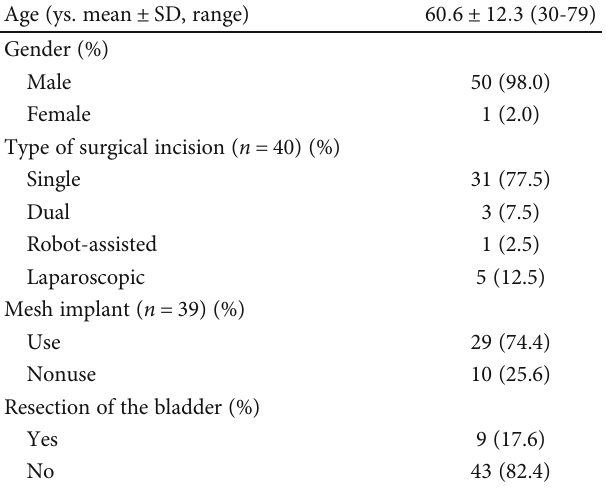
Table 1: Demographics of 51 patients with inguinal bladder hernia. Age (ys. mean ± SD ,